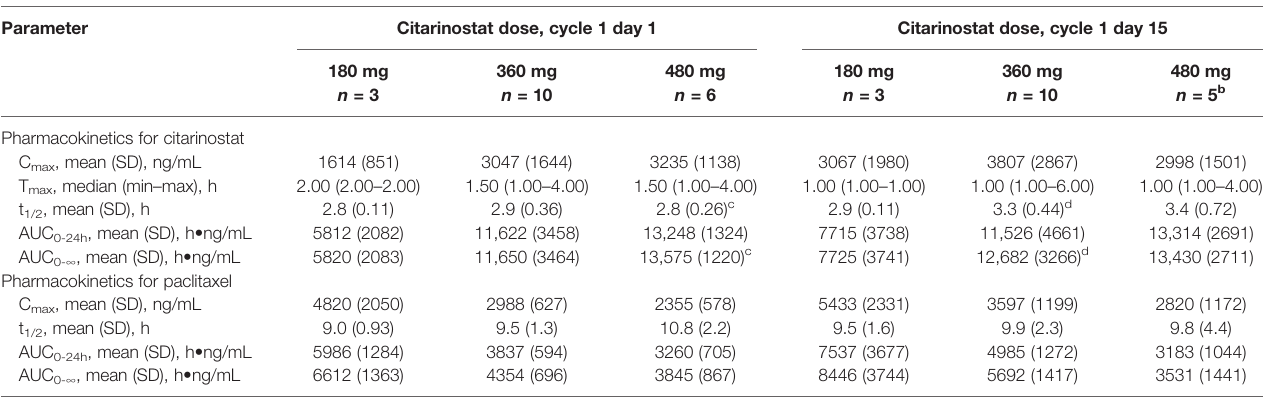
TABLE 4 | Citarinostat and paclitaxel pharmacokinetics at different citarinostat doses. a